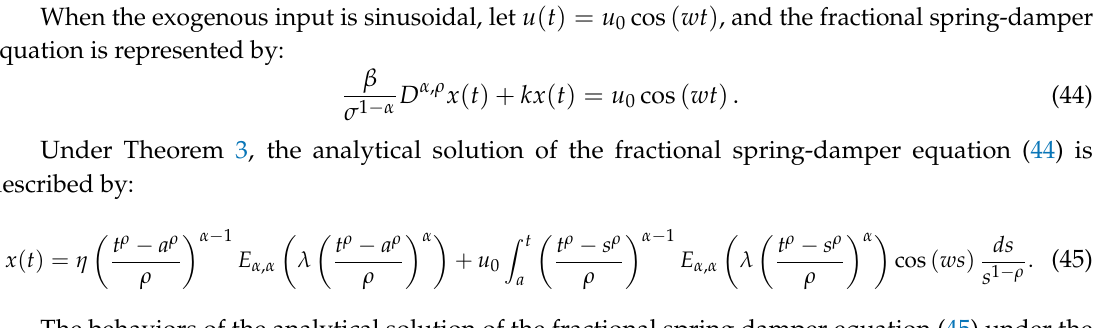
Figure 9. Numerical simulation for Equation (43) considering different values of α , arbitrarily